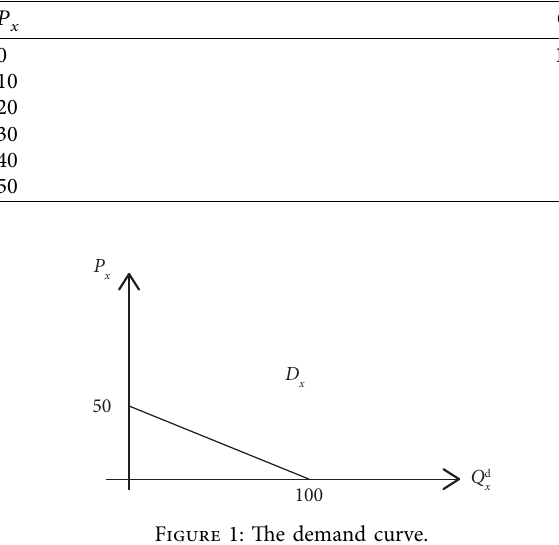
Figure 1: Te demand curve.